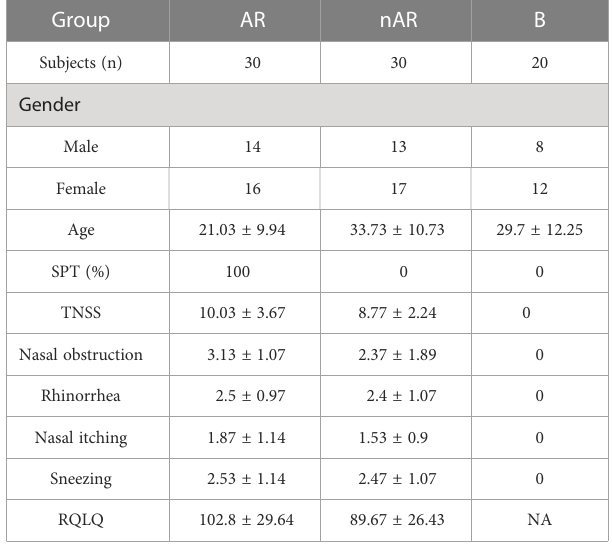
TABLE 1 Clinical characteristics of AR and non-AR